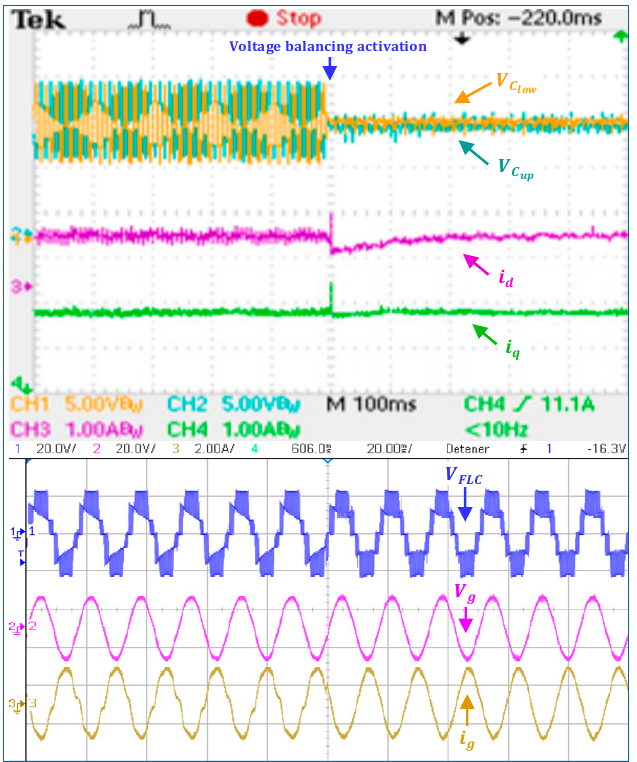
Figure 12. Performance of the voltage balancing strategy and the vector control for the proposed grid-tied SPFLC during steady state of the 𝑑𝑞 grid currents.